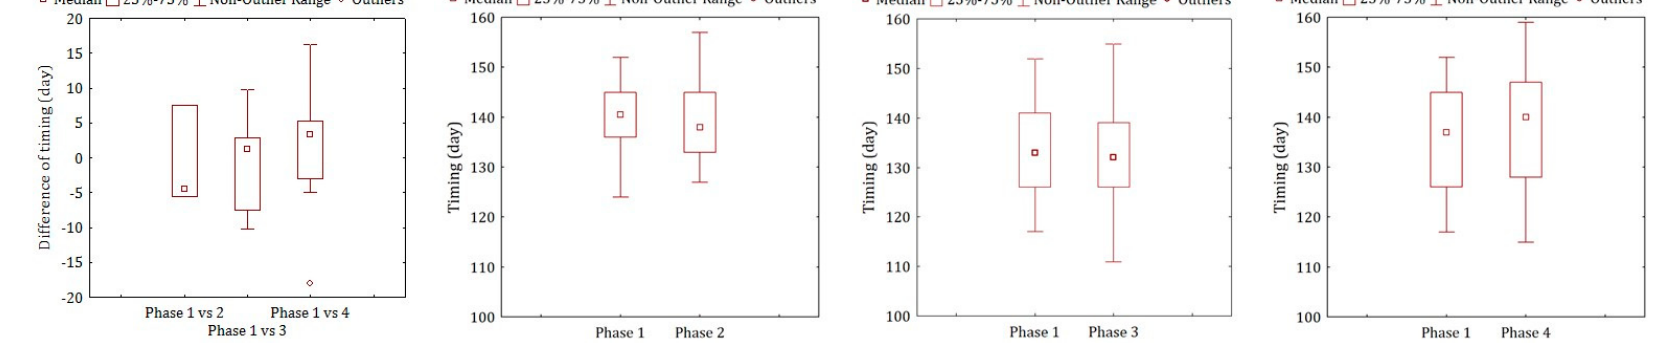
Figure 9. The comparison of timing of low flows in different phases during the forest harvesting period.